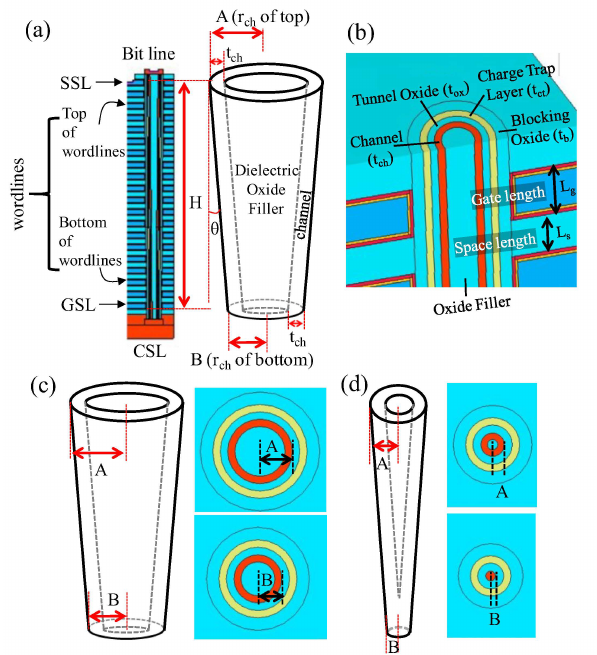
Figure 4. ( a ) Cross-sectional view of the 3D NAND structure along the z-direction. ( b ) 3D bird’s-eye view of the 3D NAND structure. ( c ) Cross-sectional view of the non-aggressively-scaled-down channel hole in the xy-plane at top/bottom WL. ( d ) Cross-sectional view of the very-aggressively- scaled-down channel hole in the xy-plane at top/bottom WL. In the very-aggressively-scaled-down channel hole of the 3D NAND structure, A and B decrease due to the tapered shape of the channel